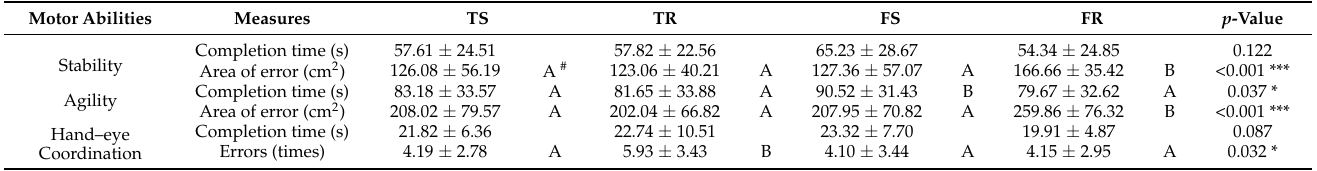
Table 2. The differences between the four Chinese brush operations on the stability, agility, and hand–eye coordination tests. Motor Abilities